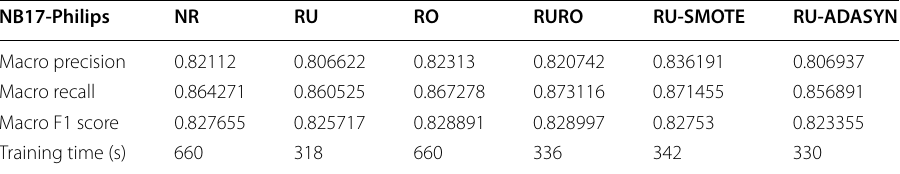
Table 44 ANN classification results for NB17-Philips on AWS with Spark for various resampling